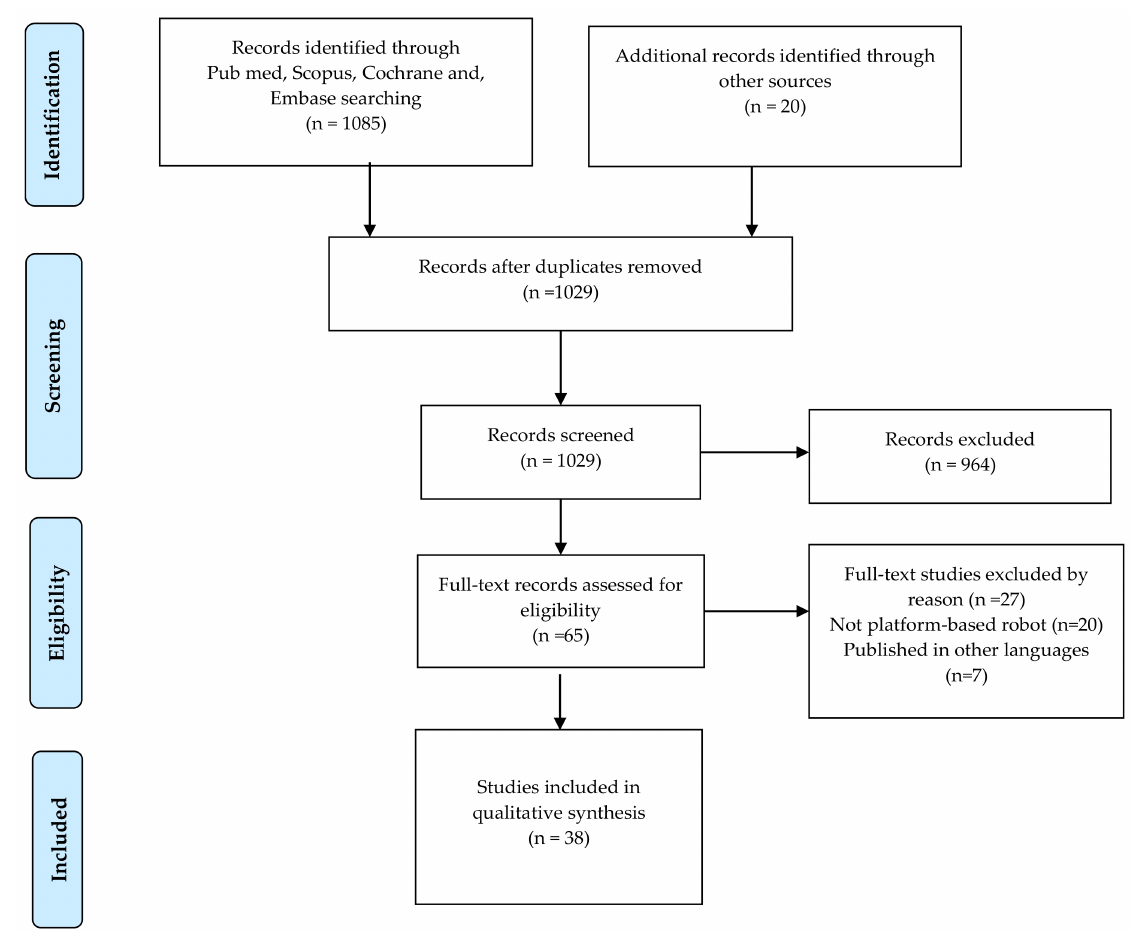
Figure 1. PRISMA Flow diagram of the records selection